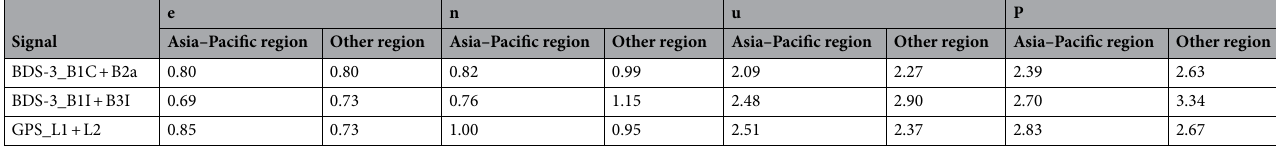
Table 7. Average of positioning errors RMS over all observation stations for dual-frequency SPP (unit: m).